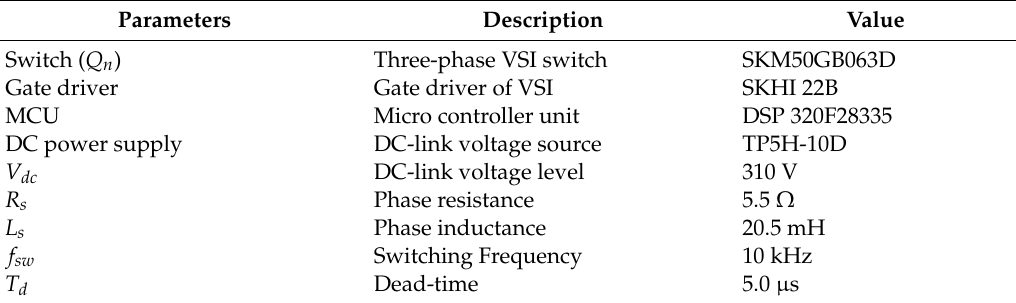
Figure 22. Experiment setting; ( a ) the three-phase VSI; ( b ) DC-power supply for the DC-link voltage source. Table 4. Experiment specifications.